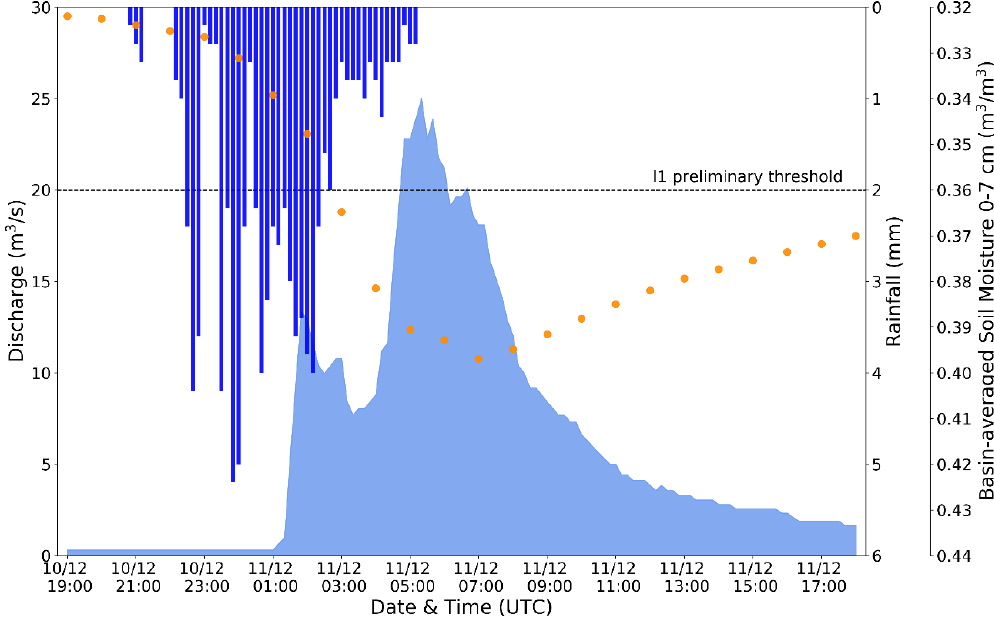
Figure 8. Timeseries of 10-min precipitation (blue bars; mm) and stream discharge (light blue filled areas; m 3 / s) over Spata meteorological station and Rafina hydrological station, respectively, and of 1-h basin-averaged volumetric (0–7 cm) soil water content (orange dots; m 3 / m 3 ) from 10 December 2009, 1900 UTC, to 11 December 2009, 1800 UTC.